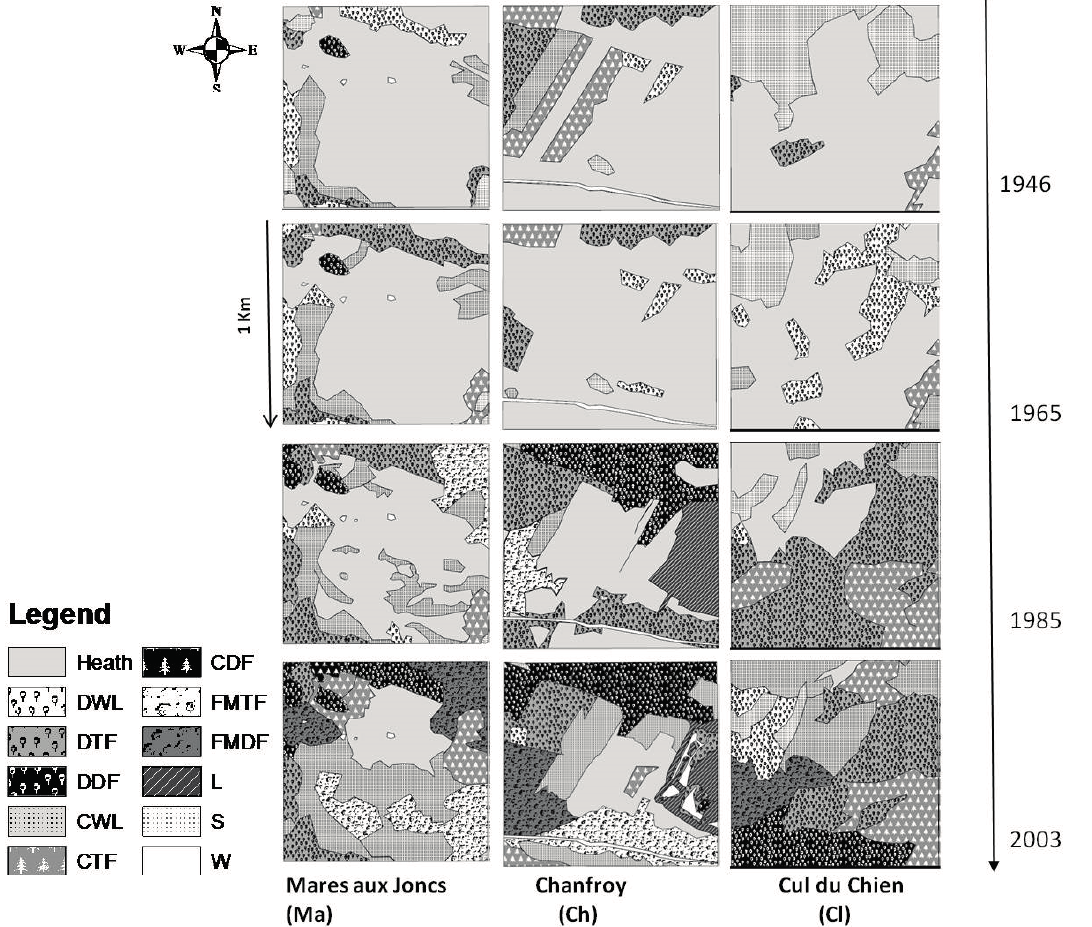
Figure 4. Habitat maps for 1946, 1965, 1985, and 2003. The grey scale palette used for presenting the maps aims at reflecting the secondary succession progression between open areas (clear colours) and woodlands (darker colours). Bare soil (S), Heathland (Heath), Conifer woodland (CWL), Deciduous woodland (DWL), Conifer thin forest (CTF), Deciduous thin forest (DTF), Conifer dense forest (CDF), Deciduous dense forest (DDF), Mixed forest thin forest (FMTF), Mixed forest dense forest (FMDF), Lawn (L), Water